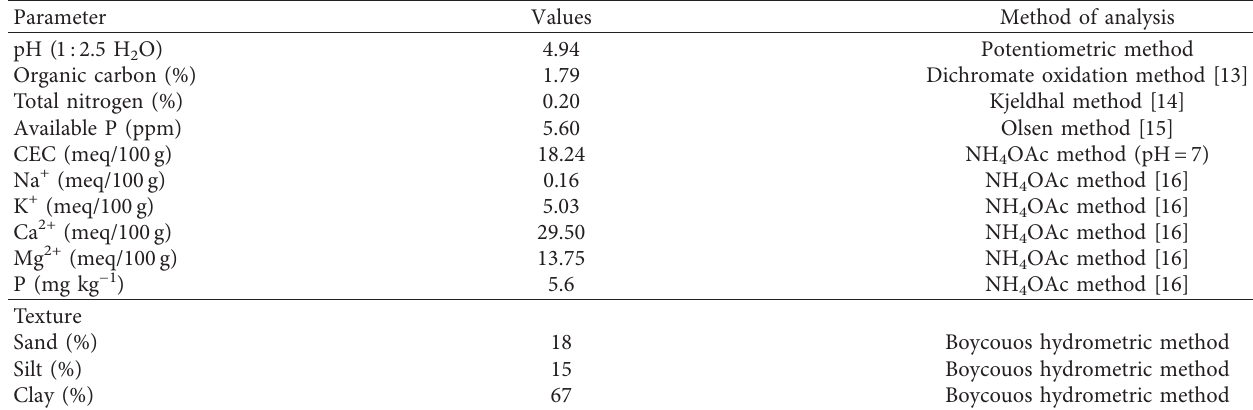
Table 1: Properties of soils in the study area.